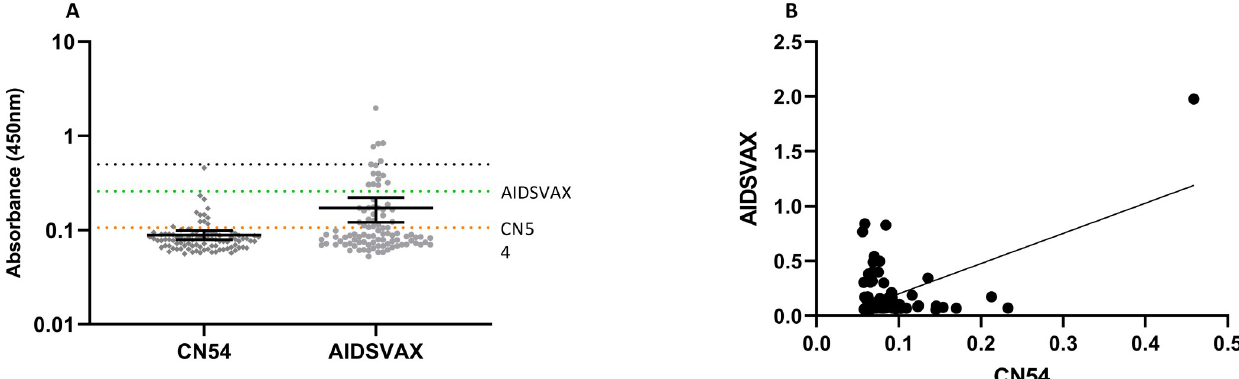
Fig 3. Assay Cut-off determination for CN54 and AIDSVAX BE ELISA. A–Assay cut-off determination. Orange line represent calculated assay cut off for CN54 ELISA. Green dotted line represents calculated assay cut off for AIDSVAX BE ELISA. Grey dotted line represents final assigned assay cut-off. B–CN54 and AIDSVAX BE sensitivity sample correlation